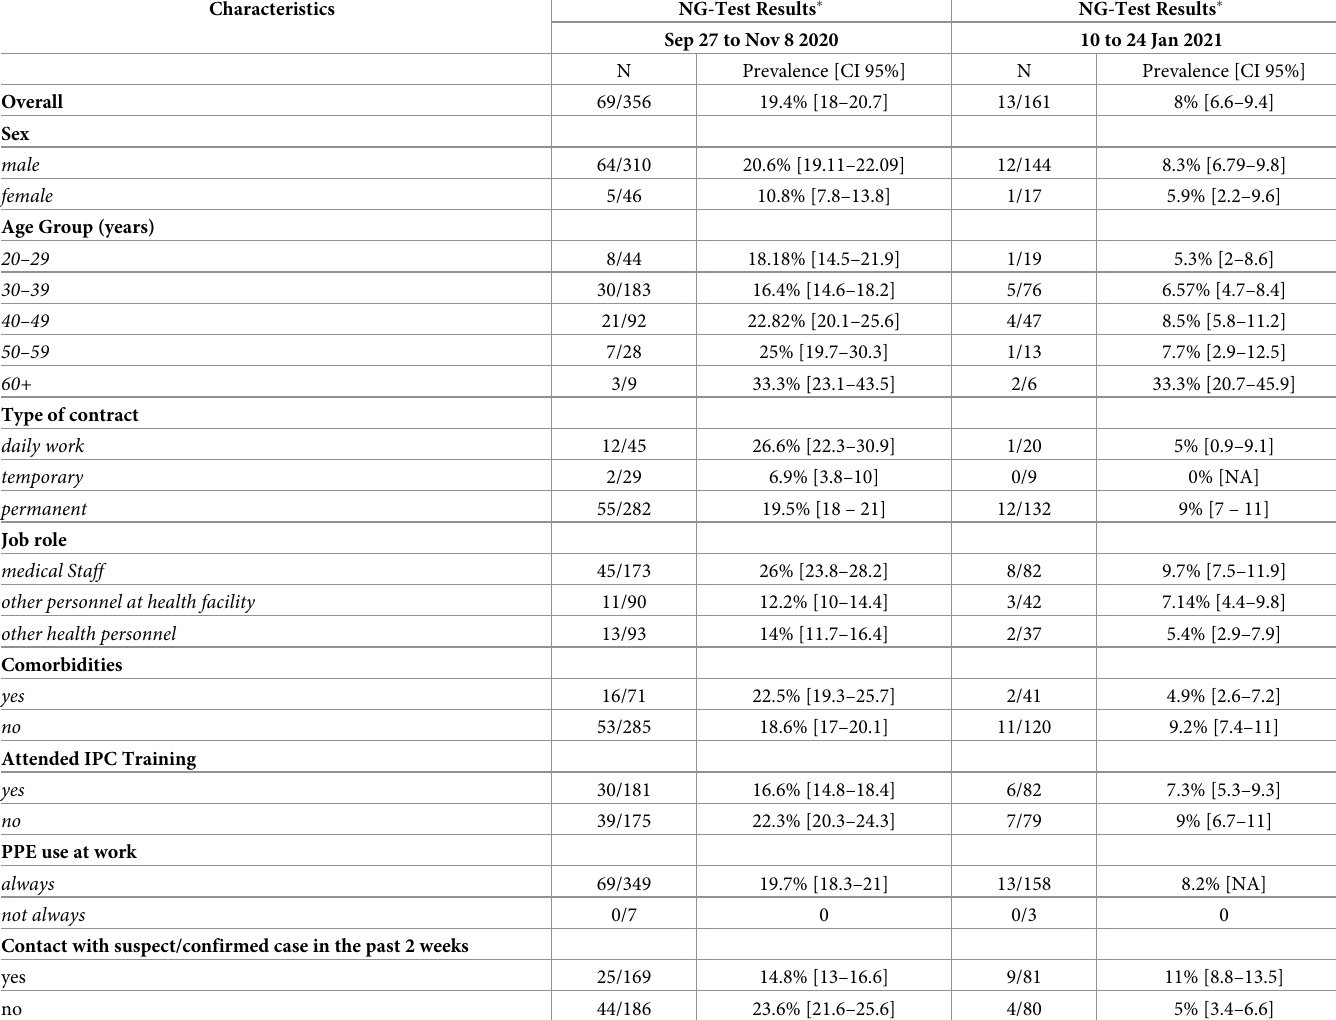
Table 1. SARS-CoV-2 seroprevalence results detected by NG-Test in MSF Aden Trauma Center during follow-up screenings from 27 Sep to Nov 8 2020 and a final screening from 10 to 24 Jan 2021.